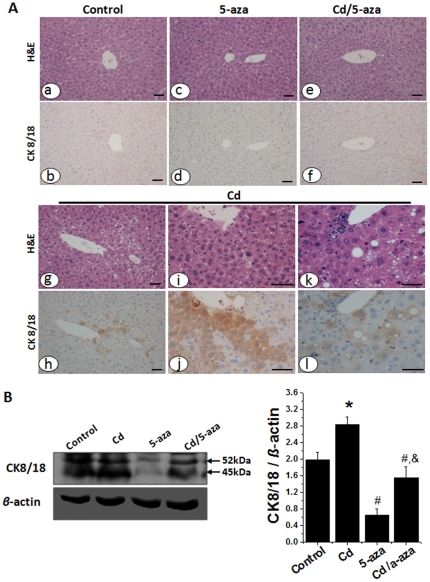
Effects of chronic exposure to Cd on CK 8/18 expression in mouse livers.Expression of hepatic CK8/18 as a new marker of mouse liver preneoplastic change was examined by immunochemical staining (A) and Western blotting (B). In panel A, series of sections of same tissues were conventionally stained with H&E (A-a, c, e, g, i, k) and immunochemically stained with anti-CK8/18 antibodies (A-b, d, f, h, j, l). The results indicated that there was a significant increase in CK8/18 staining foci with little notable change in the same locations using H&E staining. Bar = 50 µm. Data was presented as mean ± SD (n = 10). * p<0.05 vs control; # p<0.05 vs Cd group; &
p<0.05 vs 5-aza group.